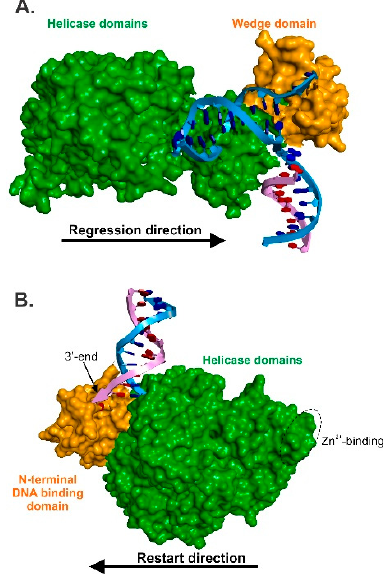
Figure 5. Replication fork rescue helicases. (A), RecG and (B), PriA. Each enzyme is represented as a Connolly surface. For RecG, a molecular model of the Escherichia coli enzyme is shown with the wedge domain colored orange and helicase domains in green. Adapted from reference [58]. For PriA, the N-terminal DNA binding domain is colored orange and the helicase domains are colored in green. The location of the zinc-binding sites is indicated by the dashed circle. Adapted from reference [82].